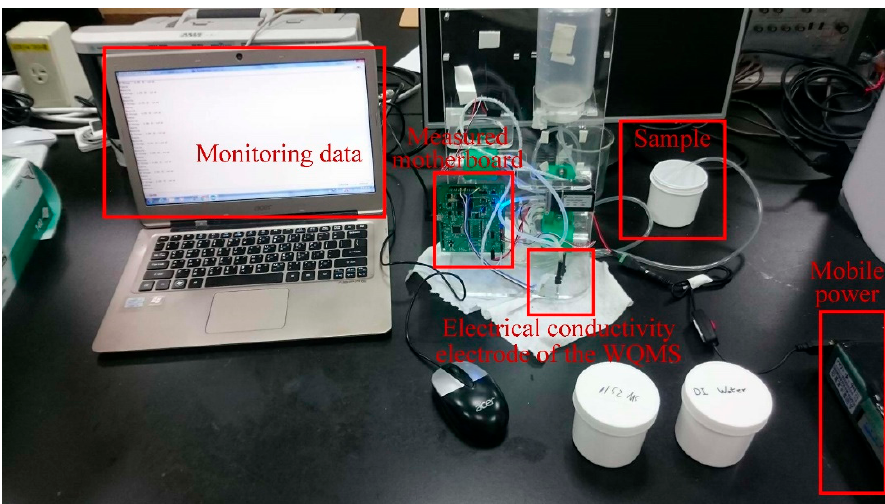
Figure 10. The experimental setup for measuring electrical conductivity.